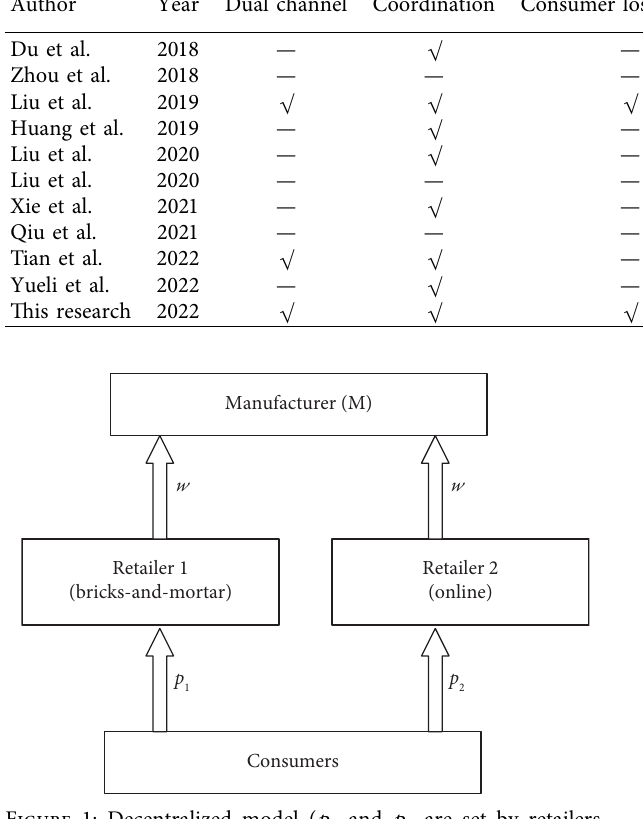
and p are set by retailers, 1 2